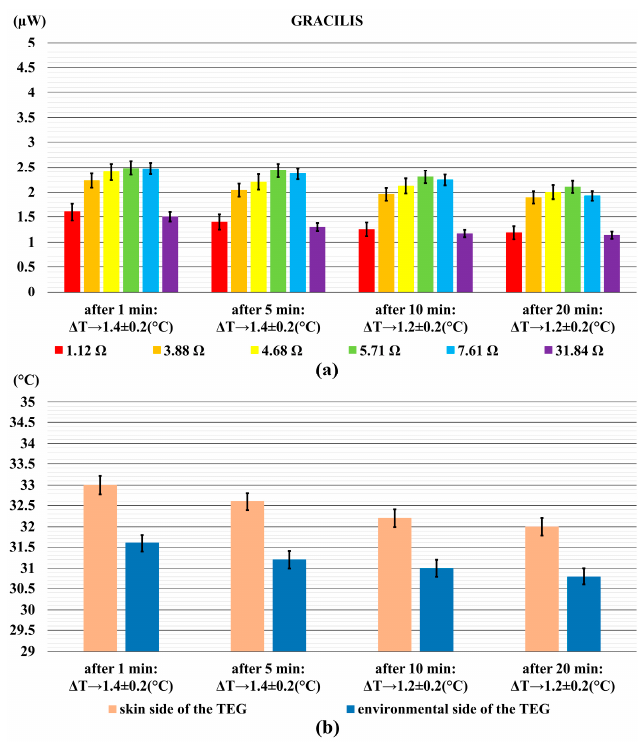
Figure 6. The power output generated by the TEG on the thigh, (gracilis muscle) ( a ); and the relative temperature difference ( b ). Error bars represent standard deviations.